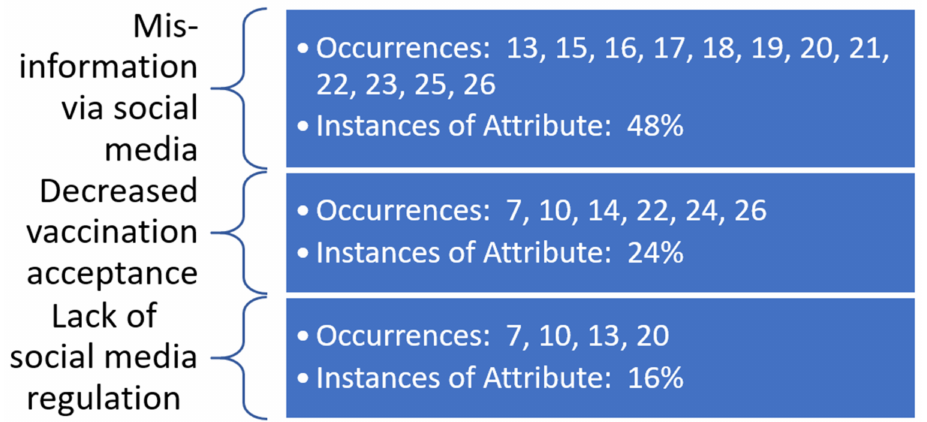
Figure 3. Occurrences of underlying themes identified as barriers to COVID-19 vaccine promotion in social media as observed in the